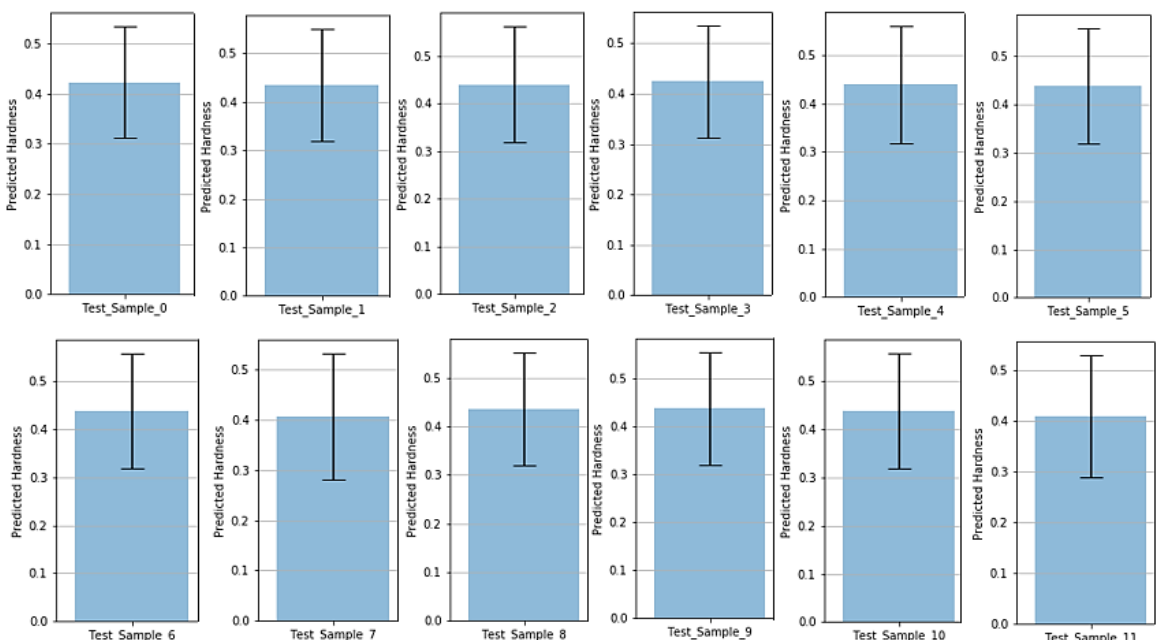
Figure 4. Mean squared error as a function of the number of epochs: a diverging model. We also generated, for each test sample, the hardness predictions of all 500 models trained. Then, the uncertainty error bars were plotted using standard deviation as the metric, which are shown in Figure 5. As expected, there existed some variance among the predictions of all 500 models.